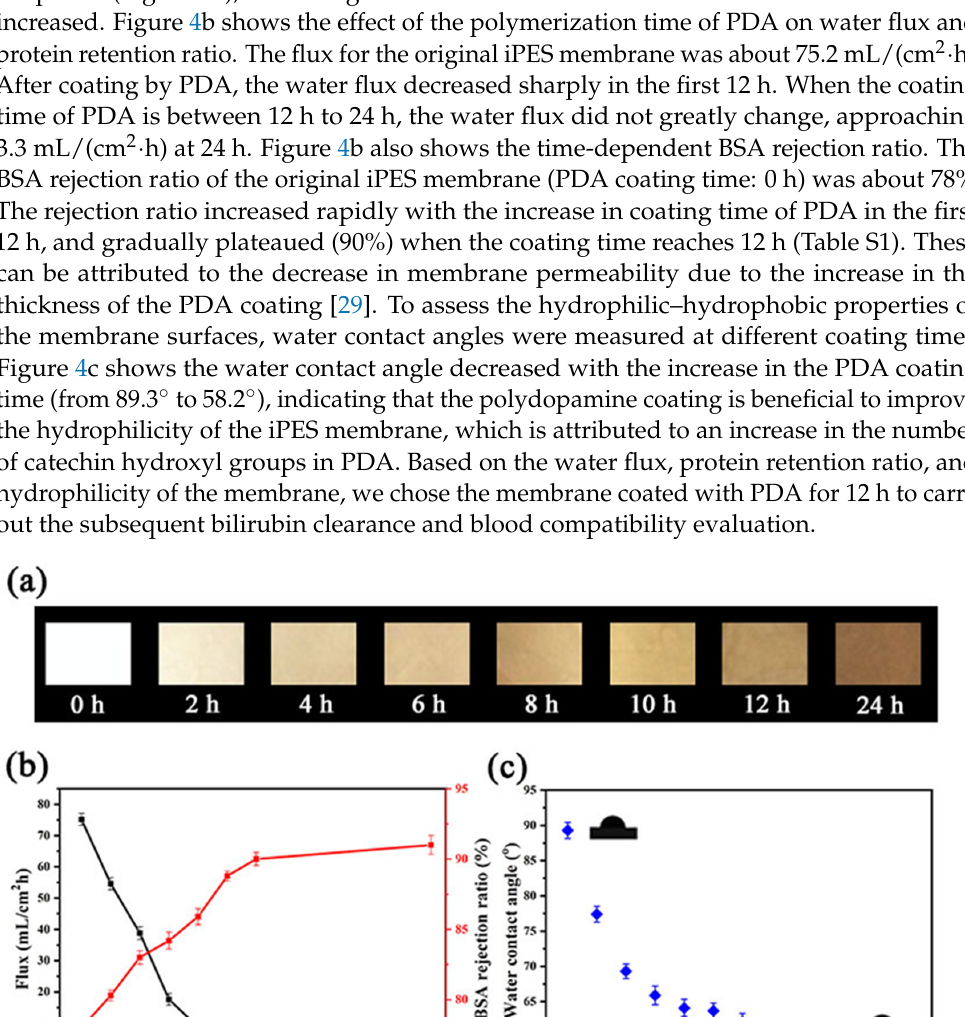
Table 1. The blood contact angle of the membranes.